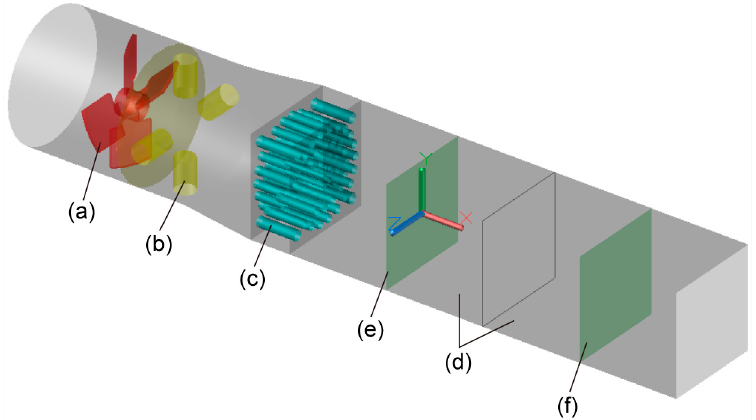
Figure 1. Test device structure description and monitoring surface position diagram. ( a ) fan; ( b ) humidifier pipe section (water mist inlet); ( c ) heating pipe section and rectifier orifice plate; ( d ) two sections of test pipe; ( e ) monitoring surface A; ( f ) monitoring surface B.